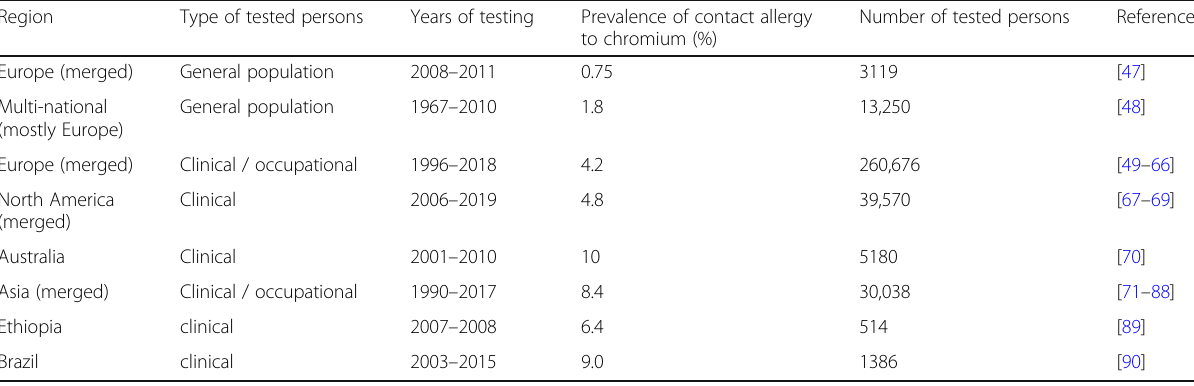
Table 1 Summary of selected data on the prevalence of chromium allergy in the general population and different clinical/ occupational groups in different continents and countries. The data are merged for Europe, Asia, and North America. A detailed overview is given in the supplementary file, Table